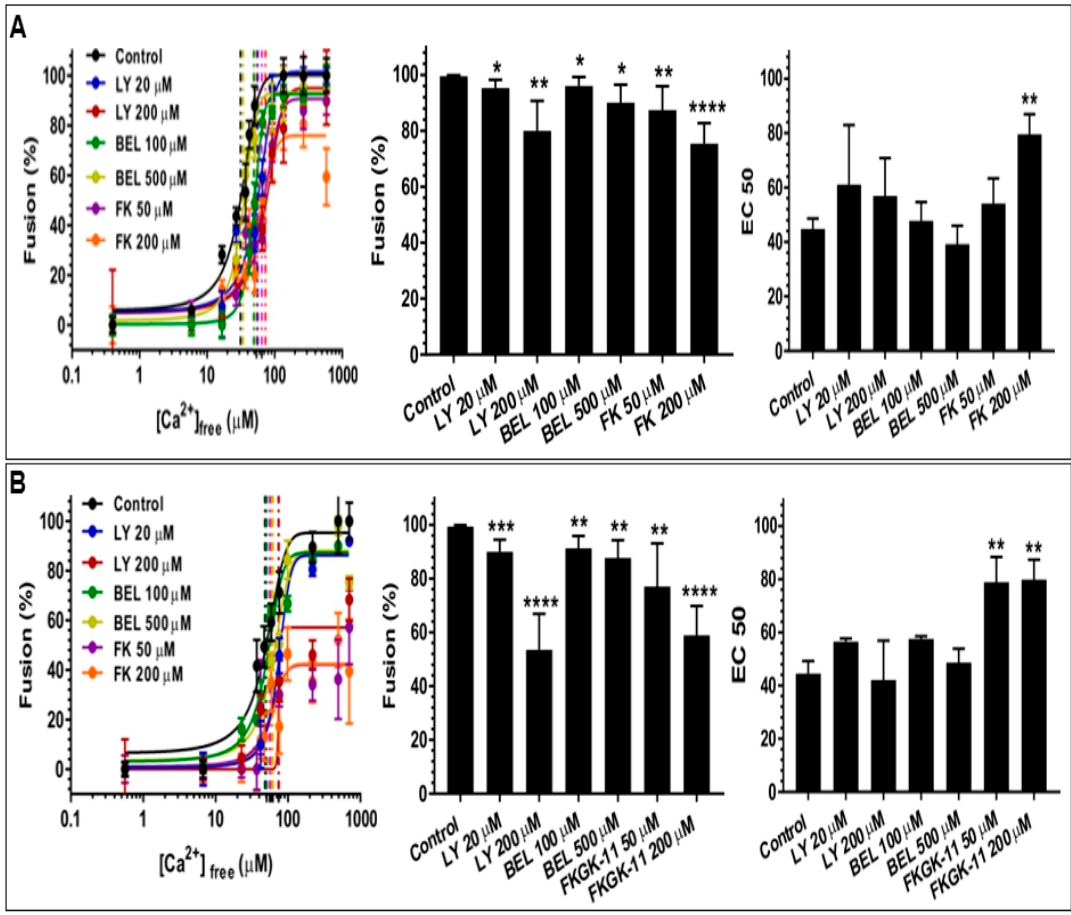
Figure 7. E ff ects of LY311727 (selective for sPLA 2 ) and BEL and FKGK-11 (both selective for iPLA 2 ) on CV-CV Ca 2 + activity curves, fusion extent and Ca 2 + sensitivity (EC50); ( A ) standard fusion assay, n = 3–19; ( B ) settle fusion assay, n = 3–19. ( p -value, * < 0.05, ** < 0.005, *** < 0.0005, **** < 0.0001 indicates di ff erence relative to the